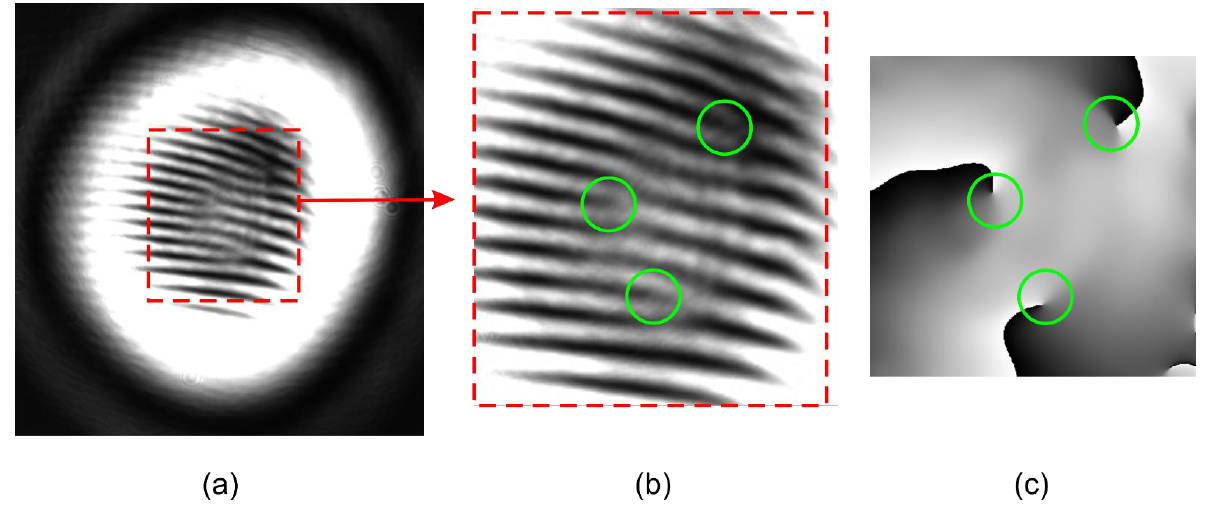
Figure 10. Experimental results with a separated optical vortex with the topological charge of m = 3. The intensity recorded with an additional beam (Figure 7): ( a ) intensity, ( b ) magnified intensity area, ( c ) phase profile. The green circles represent the locations of the vortex points.